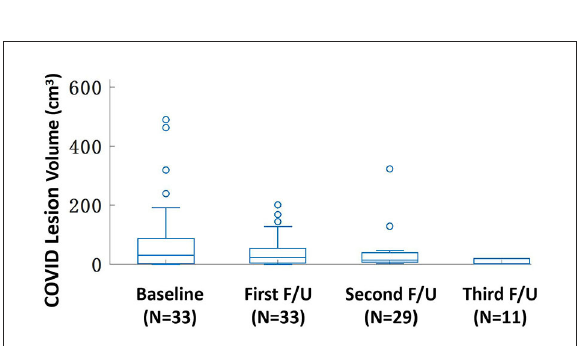
FIGURE2 The box plot of the lesion volume distribution at the baseline and three follow-up CT examinations. The median (IQR) volume (cm 3 ) is 30.9 (83.1) at baseline, 18.3 (43.9) at first F/U, 7.6 (18.9) at second F/U, and 0.6 (19.1) at third F/U. Only 11 patients have the third F/U, so the paired comparison is only done for the baseline, the first F/U, and the second F/U, all significantly different with p <